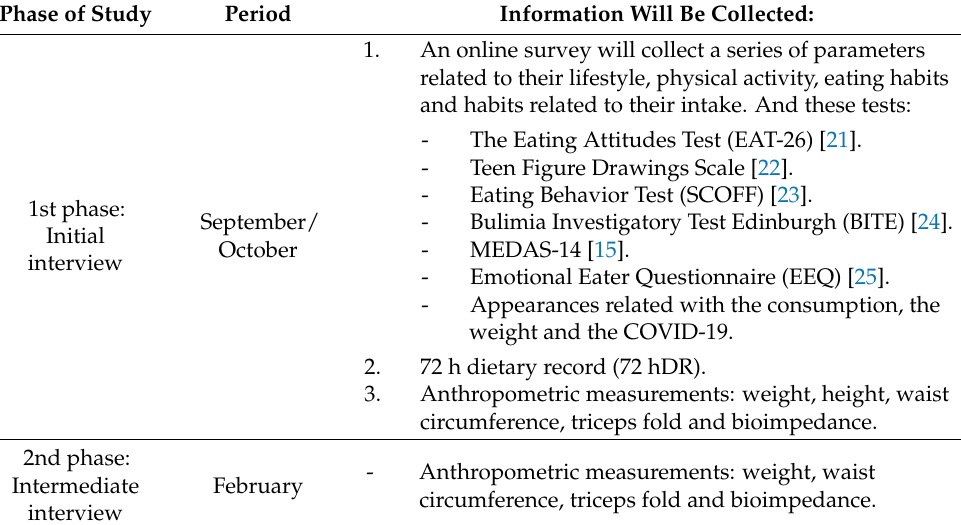
Table 1. Phases of the